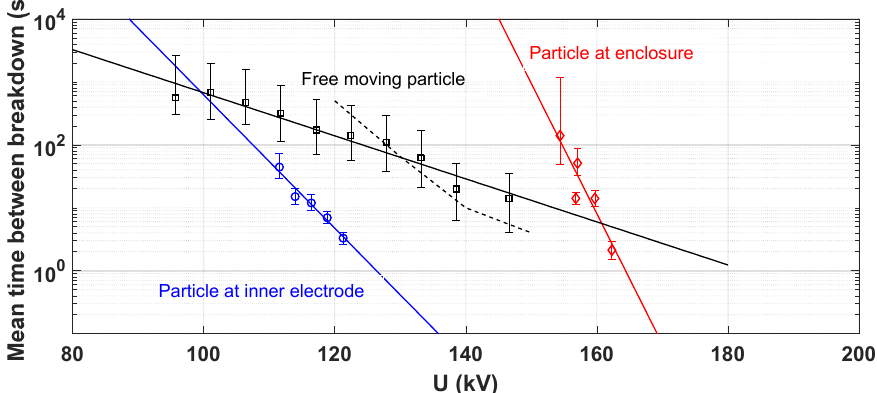
Figure 9. Mean time between breakdown in set-up 2 as a function of the applied voltage for a 4 mm particle in CO 2 /O 2 at 0.75 MPa, attached to the enclosure, to the inner electrode, or freely moving. The error bars indicate the 95% confidence interval. The solid lines give fits to the data (4). The dashed line is from simulations (see Section 4.4).